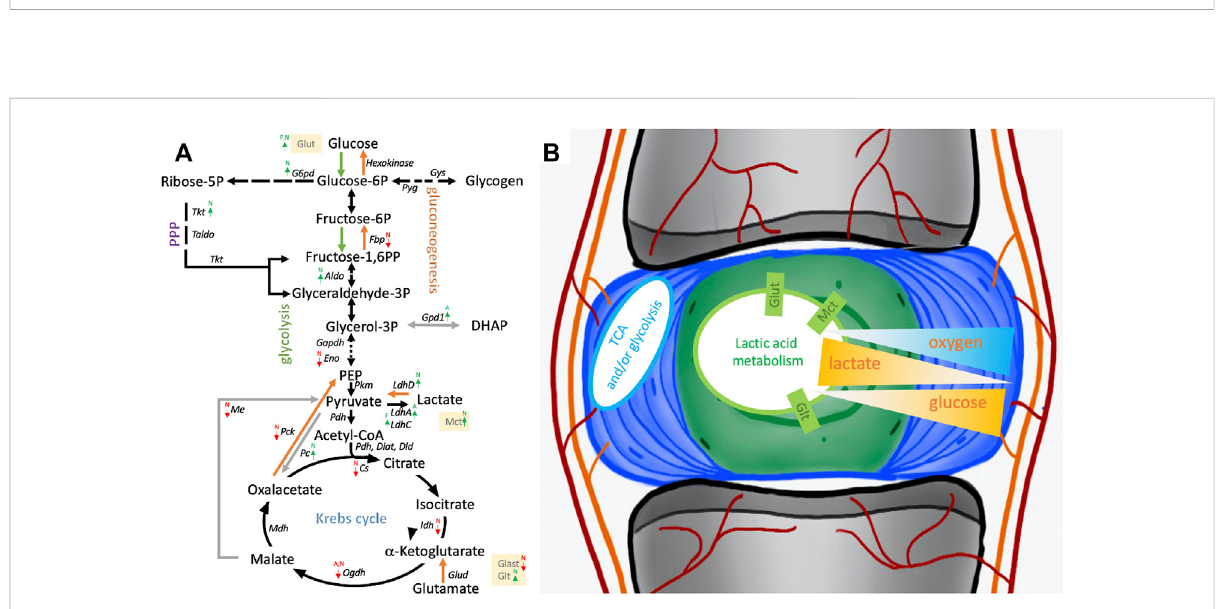
FIGURE 8 Schematic of pathways involving glucose and lactate metabolism. (A) Arrows indicate differentially expressed transcripts encoding for an enzyme or transporter in cells derived from the nucleus pulposus (N), annulus fi brosus (A), or adipose (F) tissue. (B) Illustrates NP niche conditions, metabolic pathways and gradients of crucial contributors to the NP niche condition alongside their transporters. Cells were isolated from a single donor to avoid the genotype effect. Cells were analyzed as three replicates for AF and NP and two replicates for FAT cells. P, phosphate; PPP, pentose phosphate pathway; TCA, tricarboxylic acid